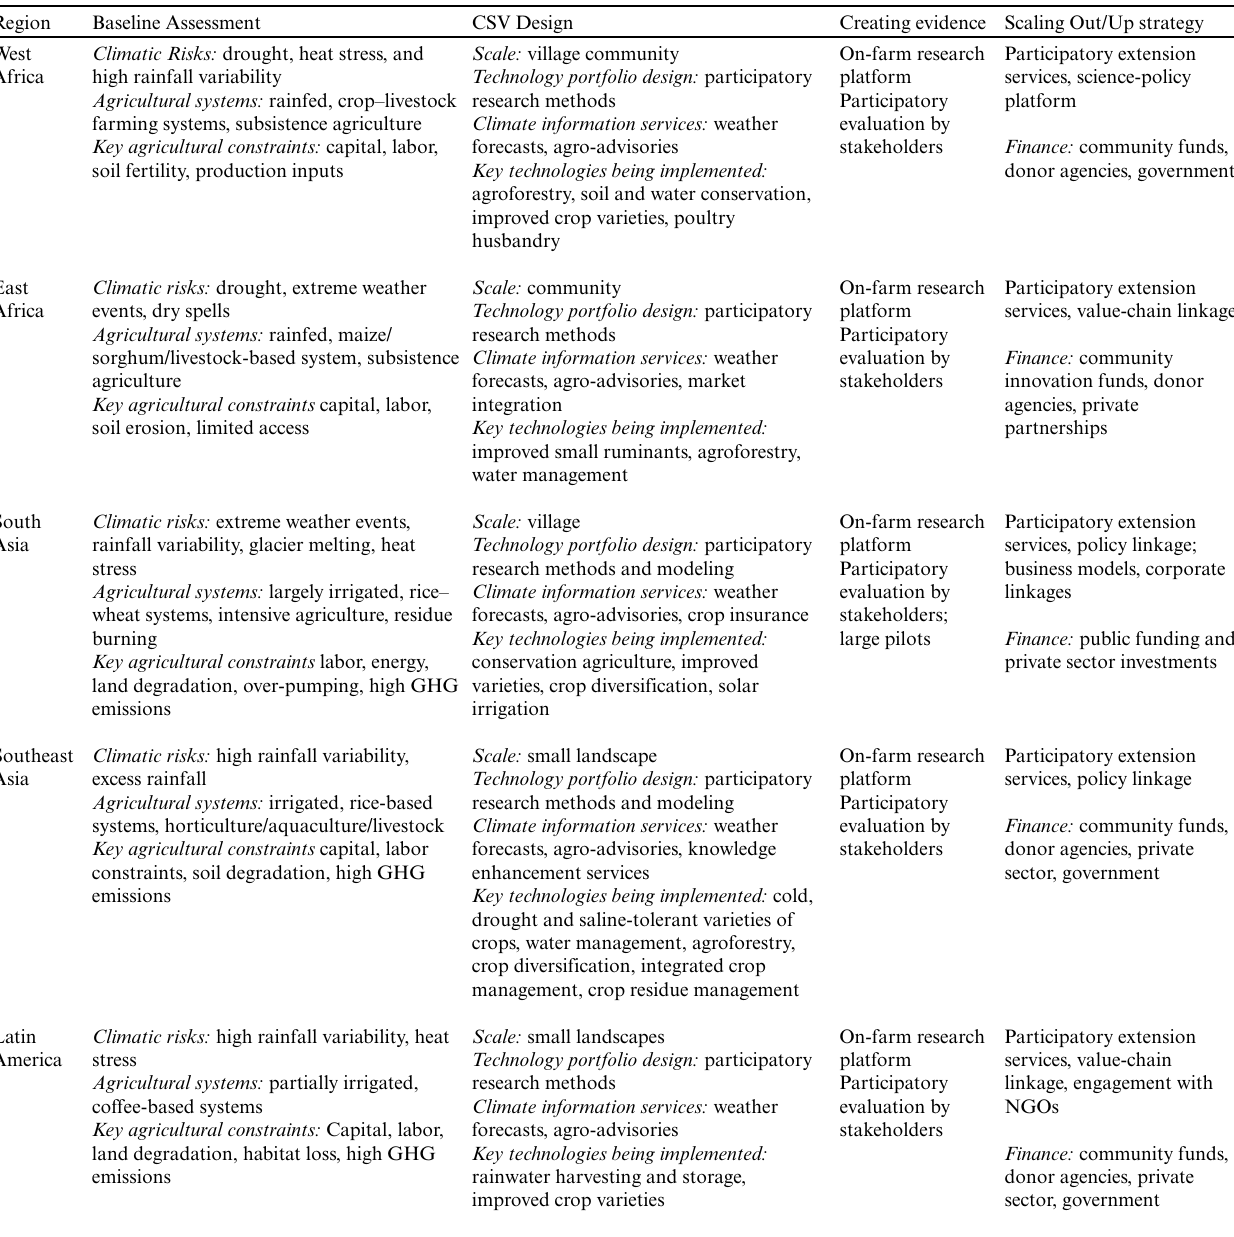
Table 1. Diversity in CSV AR4D approach used in various CCAFS regions